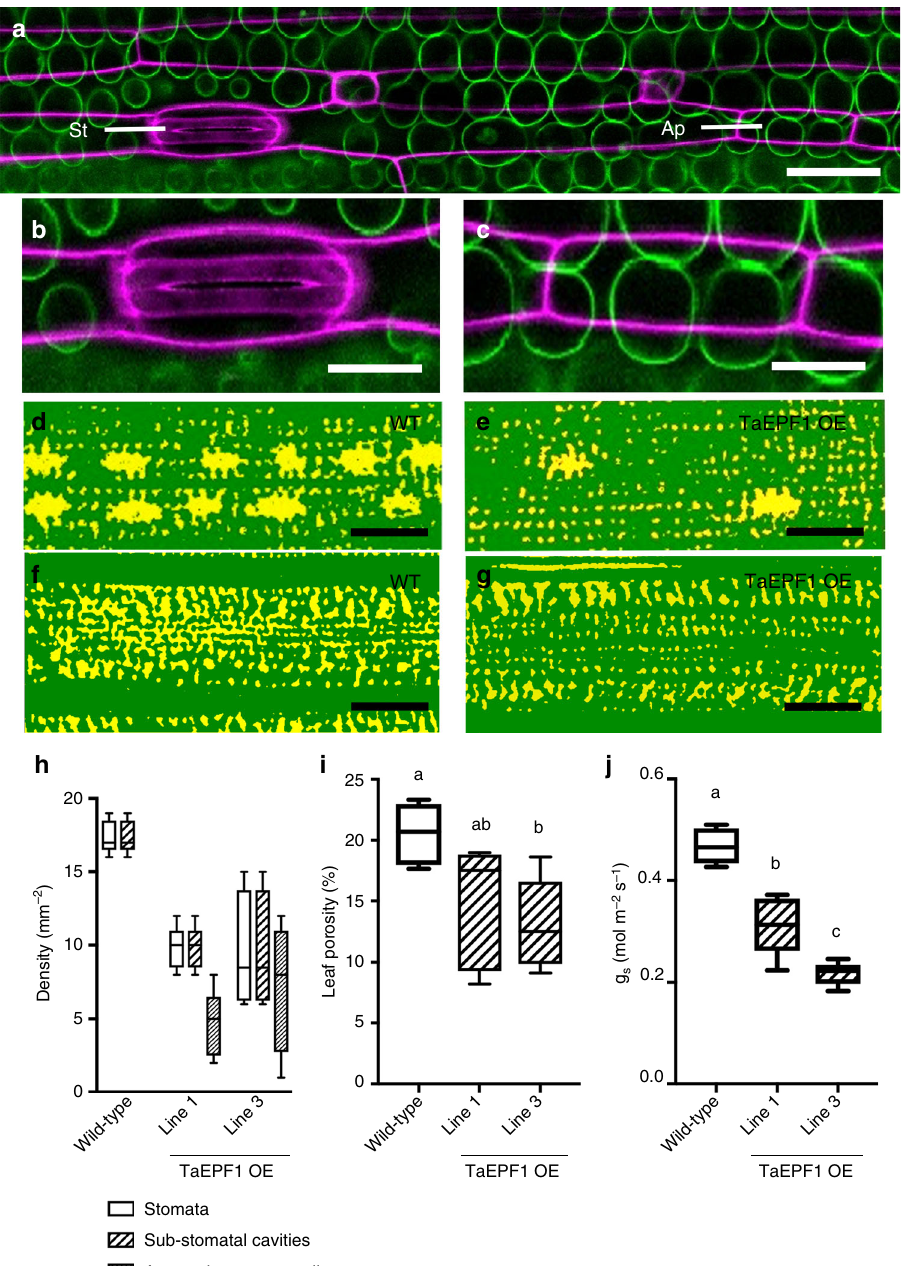
Fig. 3 EPF overexpression arrests sub-stomatal cavity development and decreases mesophyll porosity in wheat. a Confocal overview of a TaEPF1 OE wheat leaf showing epidermal layer (purple), subtending mesophyll cells (green), a stomate (St) consisting of guard cells and associated subsidiary cells and, in the same fi le, an arrested stomatal precursor (Ap). Scale bar = 60 µ m. b , c Higher resolution images of ( b ) the stomate and ( c ) arrested stomatal precursor cell shown in a . Scale bars = 40 µ m. d – g microCT images of a wild-type (WT) ( d , f ) and a TaEPF1 OE leaf ( e , g ) in a paradermal plane within the mesophyll directly subtending the epidermis ( d , e ) or deeper in the leaf ( f , g ), with solid tissue in green and airspace in yellow. The larger airspaces in d , e indicate sub-stomatal cavities. Note fewer sub-stomatal cavities in the TaEPF1 OE leaf. Scale bars = 100 µ m. h – j In WT wheat and two independent lines of transgenic wheat overexpressing TaEPF1 (as indicated), ( h ) the density of stomata ( n = 87), sub-stomatal cavities ( n = 87) and arrested stomata precursor cells ( n = 52 from 5 independent leaves); ( i ) mesophyll porosity as measured from microCT analysis (ANOVA, F (2,12) = 4.977, p = 0.027); and ( j ) stomatal conductance, g s , are shown (ANOVA, F (2,12) = 46.86, p < 0.0001). For i and j a posthoc Tukey analysis was performed ( n = 5). Lines sharing the same letter are indistinguishable from each other at the p < 0.05 con fi dence limit. Data ( h – j ) are shown as box plots (25th – 75th percentile, horizontal line = median) with whiskers indicating maximum and minimum